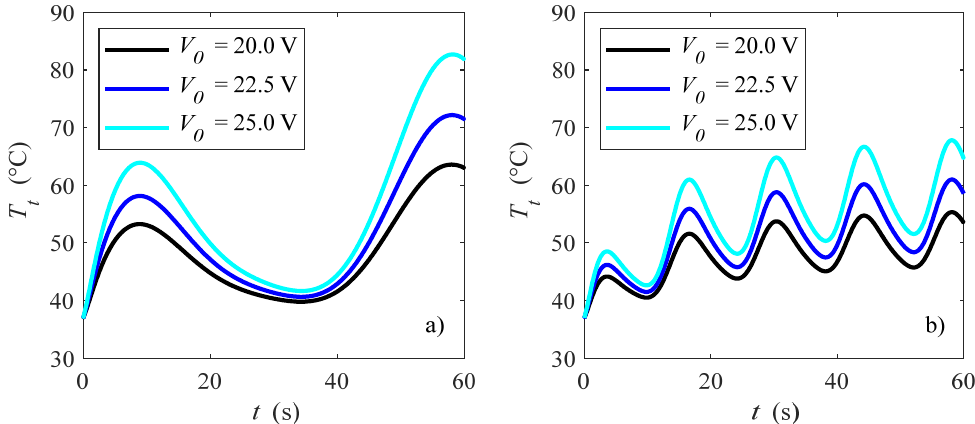
Figure 6. Tissue temperature vs. time for different applied voltages: ( a ) ω * = 0.125 and ( b ) ω * = 0.033 in P (0.0000, − 0.0400, 0.0175).